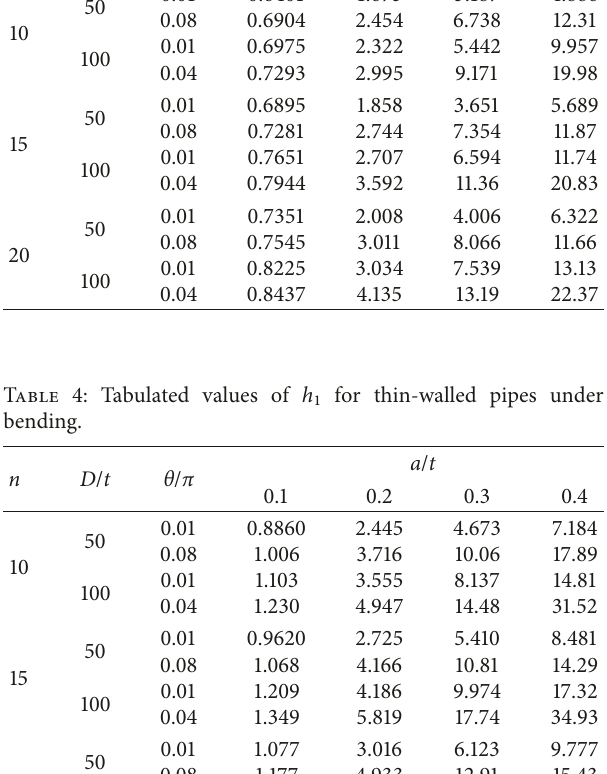
Table 2: Tabulated values of F for thin-walled pipes under bending. D / t